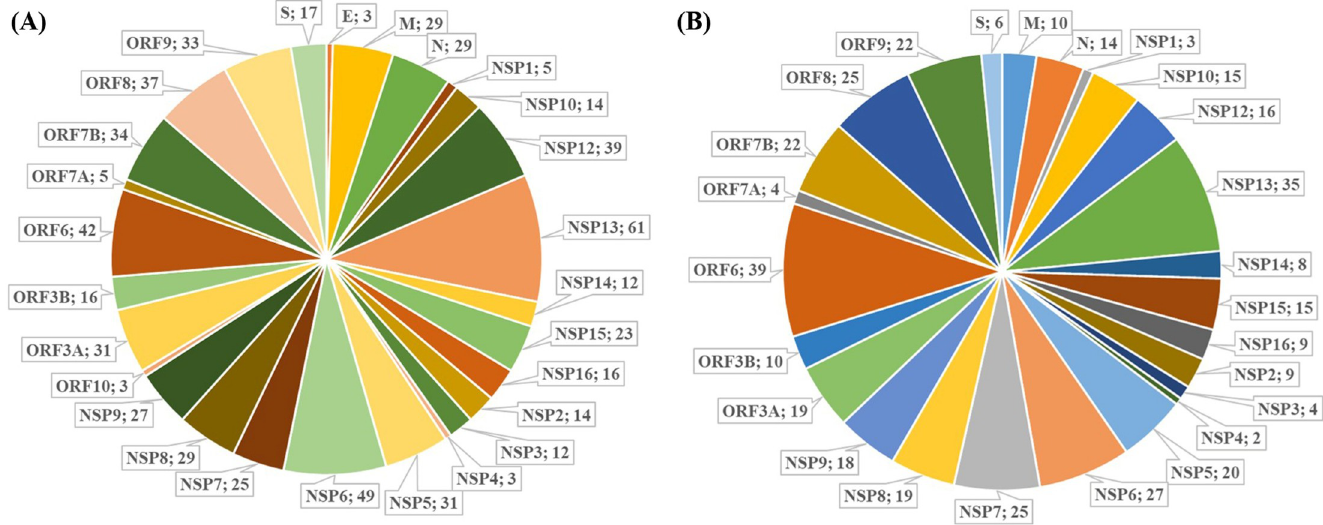
Fig 4. Effects of estradiol and retinoic acid on the drug-gene interactions network of SARS-CoV-2-human interactome. (A) Estradiol interacts with 370 (i.e., ~45%) of 809 human proteins targeted by SARS-CoV-2, making 637 interactions in total, thus possibly affecting the functions of all the SARS-CoV-2 protein in human cells. (B) Out of 809 SARs-CoV-2 human target proteins, retinoic acid interacts with 251 (i.e ~31%) proteins, making 395 interactions in total, affecting the functions of 96.2% SARS-CoV-2 protein in human cells.